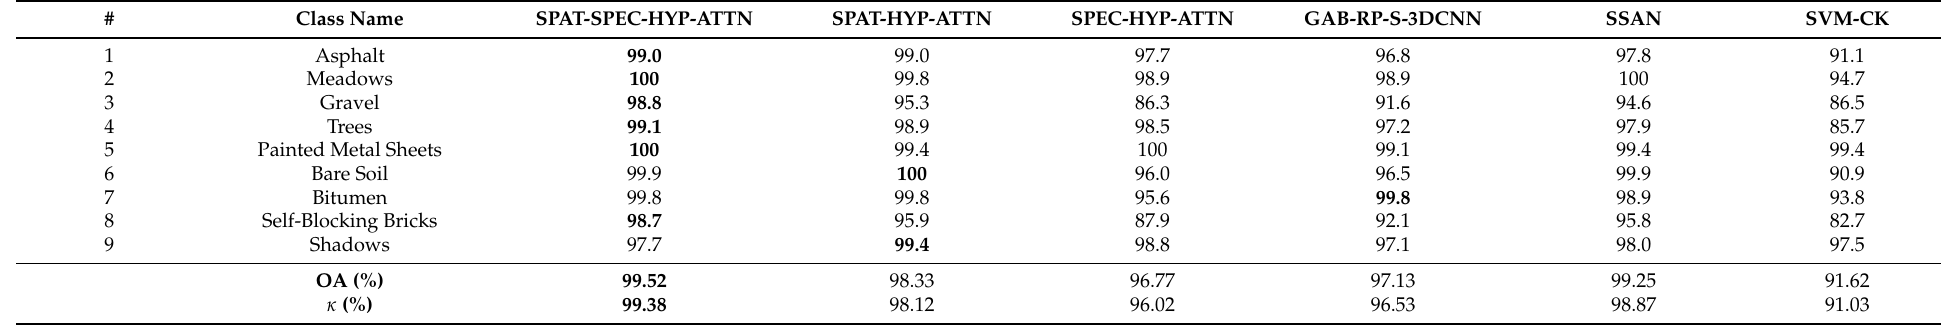
Table 5. Class-specific accuracies of Pavia University dataset for 5% of training data for the proposed classification methodologies and models used for